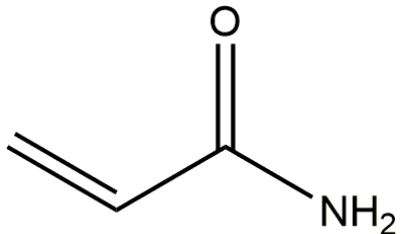
Figure 1. The chemical structure of acrylamide.